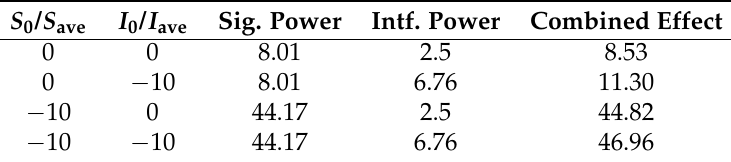
Table 1. Required backoff values for mobility induced SINR